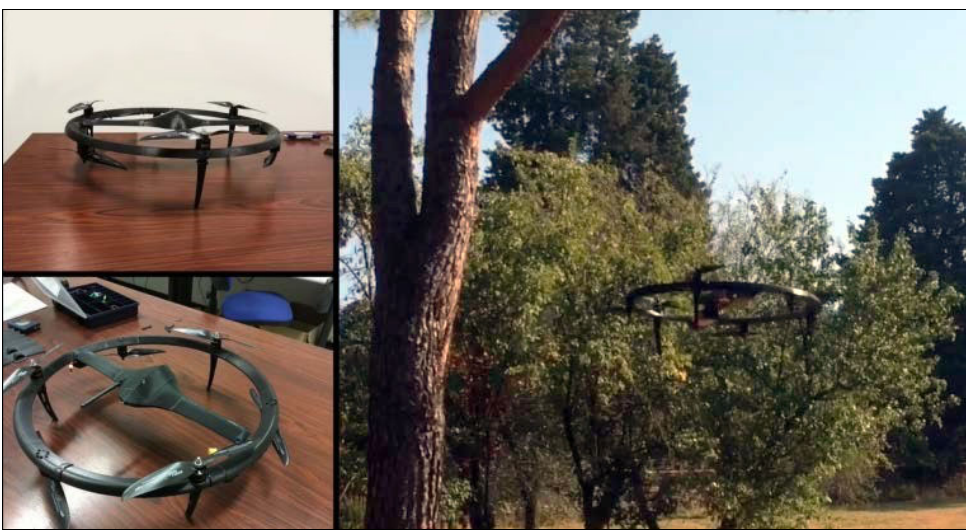
Figure 2. The Saturn Mini